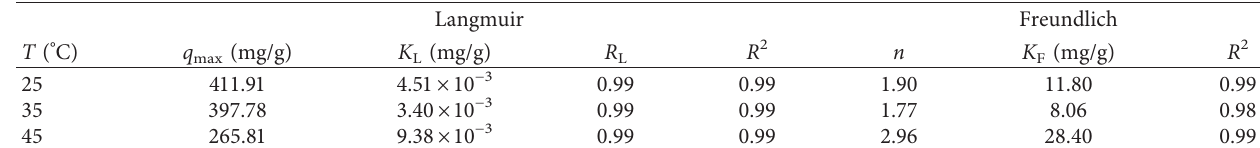
Table 5: Parameters of adsorption isotherms.